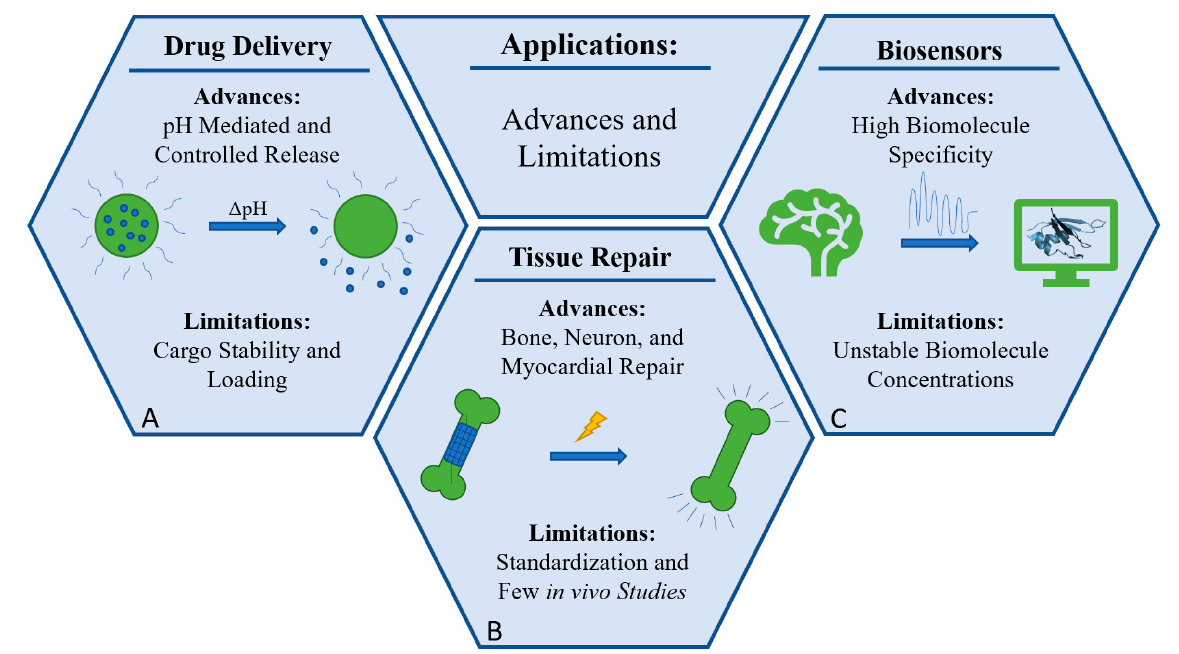
Figure 7. Potential applications of electrically conducting biomaterials are ( A ) pH mediated drug delivery platforms, ( B ) tissue regeneration matrices and ( C ) biosensors. The biosensor example displayed above demonstrates the monitoring of protein concentrations within the brain. The drug delivery diagram showcases pH mediated drug release. The tissue repair diagram shows a biomaterial that, when electrically stimulated, promotes bone regeneration. Major advances and limitations for each technology are also presented as a quick reference.